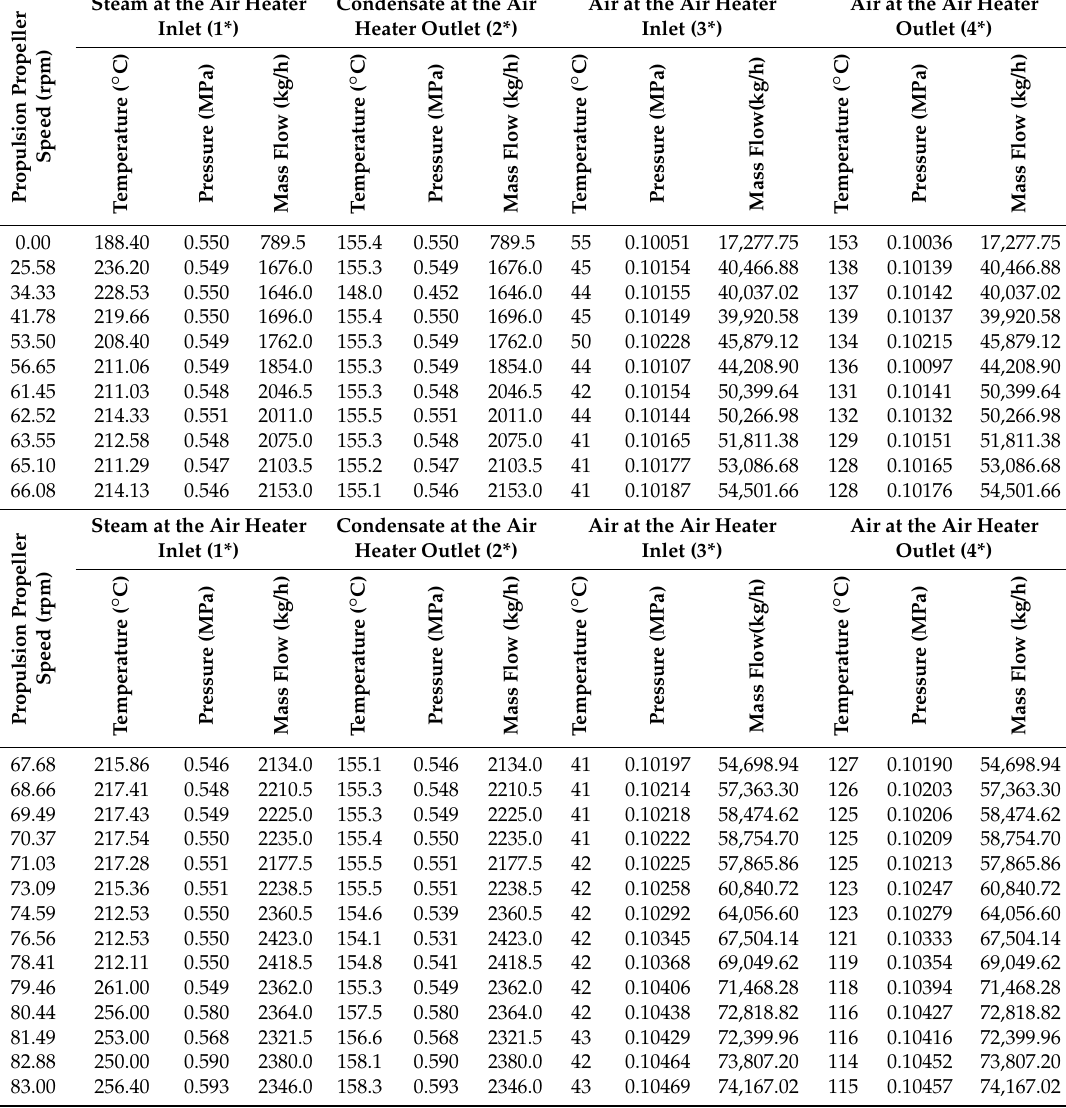
Table 2. Measurement results for steam, condensate, and air stream flows during various air heater operation regimes.